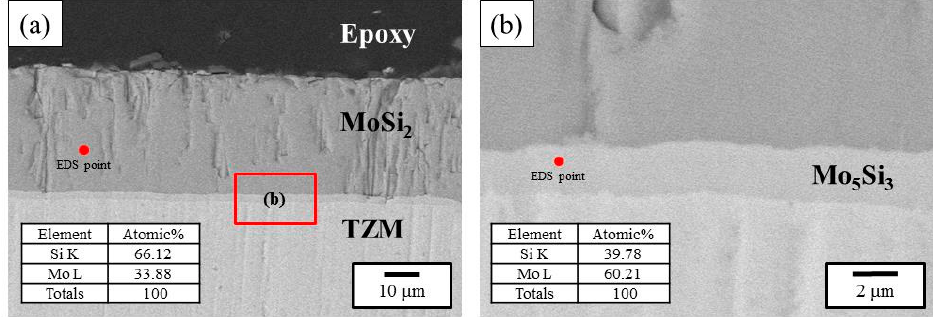
Figure 2. ( a ) Cross-section of MoSi 2 -coated TZM alloys at 1100 ° C for 6 h; ( b ) shows the enlargement of the inset in ( a ).